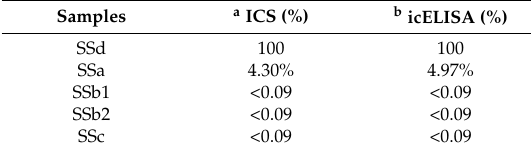
Table 1. Cross-reactivity of compounds measured by ICS and indirect competitive ELISA (icELISA).